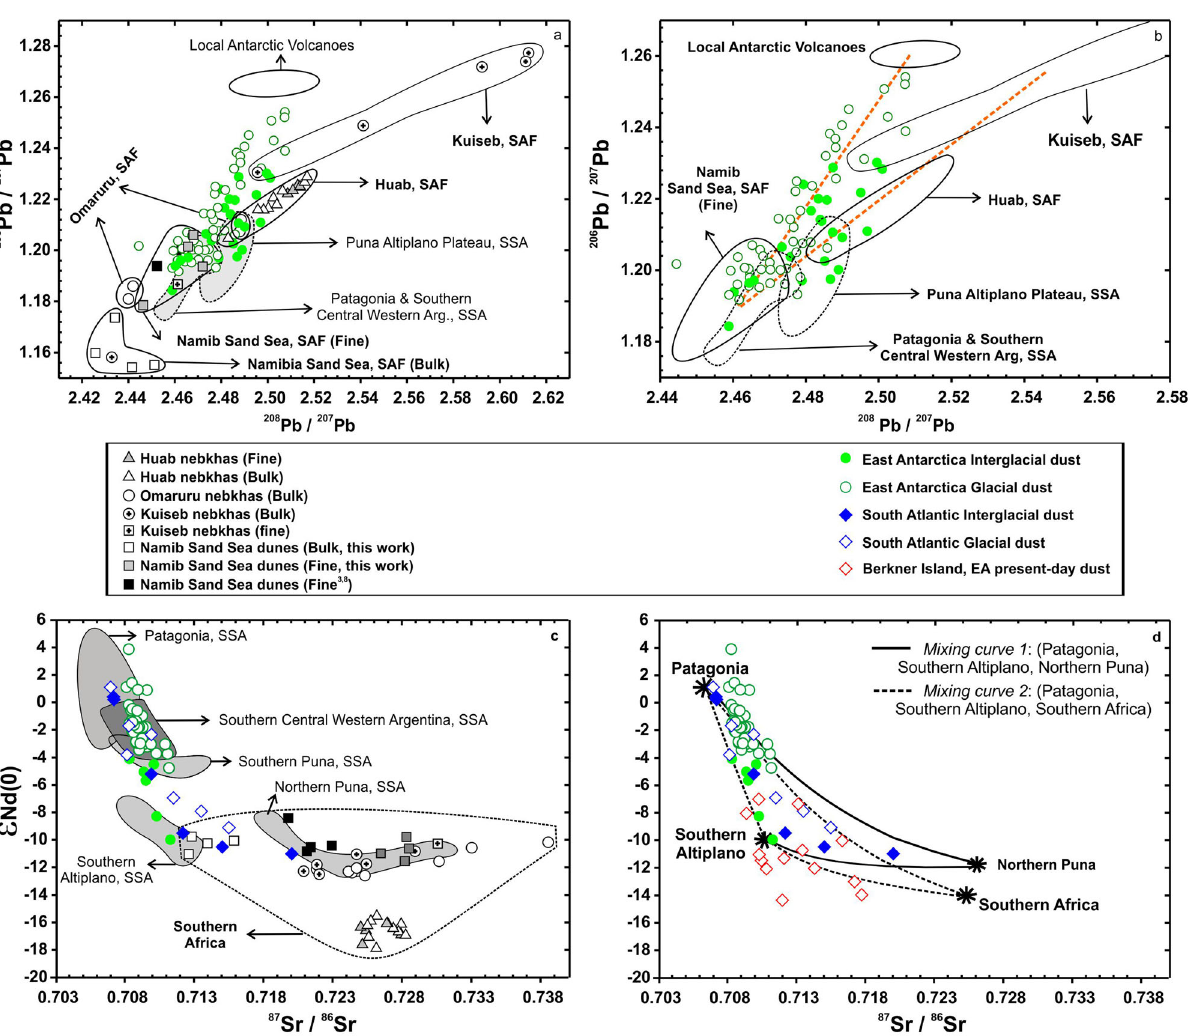
Fig. 6 Comparison of Southern Africa (SAF) and Southern South America (SSA) isotopic signatures with the glacial/interglacial fi ngerprint of dust deposited in East Antarctica and the South Atlantic sector of the Southern Ocean. a , b 208 Pb/ 207 Pb vs. 206 Pb/ 207 Pb. The orange dotted lines in Fig. 6b represent compositional trend lines necessary to explain EA dust compositions. c , d 87 Sr/ 86 Sr and ε Nd(0). The black lines in Fig. 6d represent the calculated tri-mixing hyperbola between different PSAs of SAF (dotted line) and SSA ( fi ll line). End-member values used to calculate Sr – Pb mixing curves can be found in Supplementary Table 1. Local Antarctic Volcanoes data in Fig. 6a is from 8 . SSA data from 9,10 . East Antarctica glacial/interglacial data from 3,5,8,63,70,85 . Berkner Island data from 41